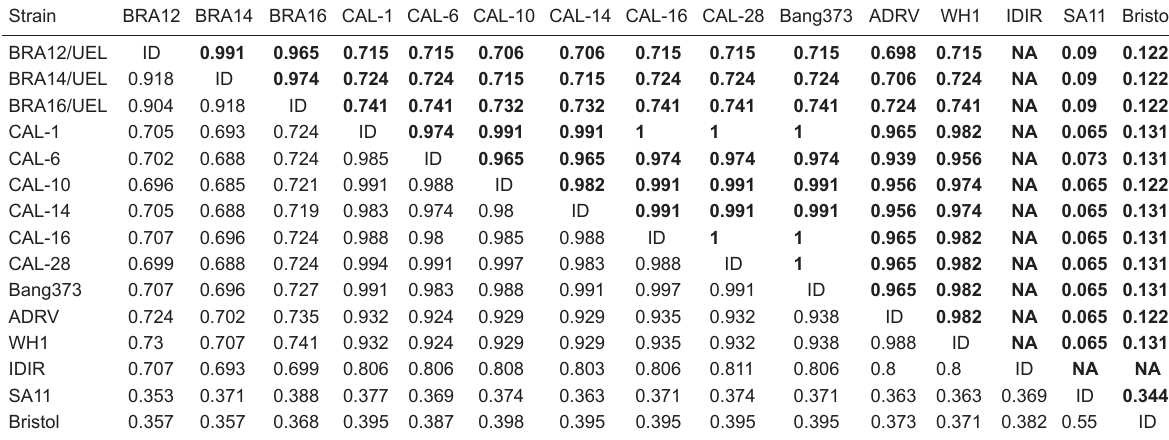
NA = sequence not